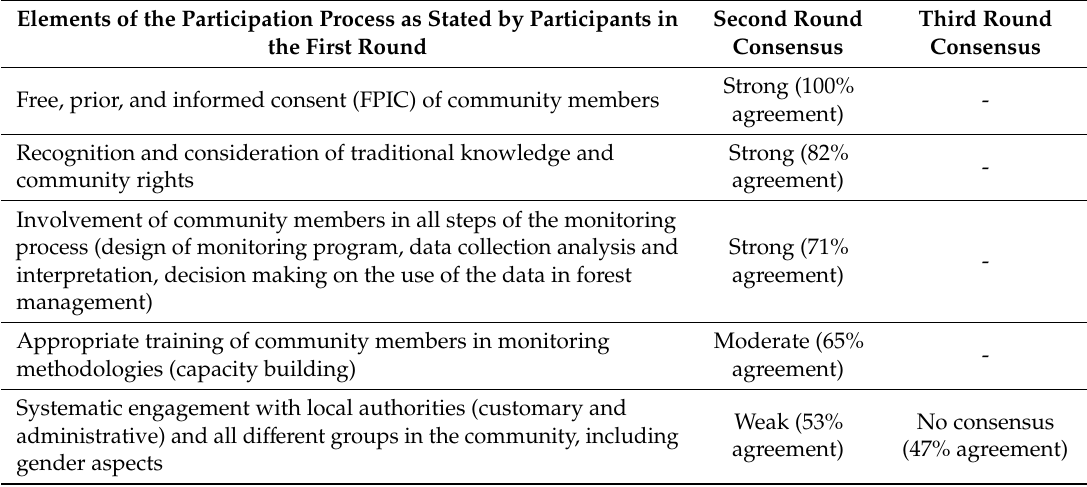
Table 2. Elements in Delphi panel results defining the process of full and e ff ective participation of communities in the monitoring of REDD + projects in the DRC.